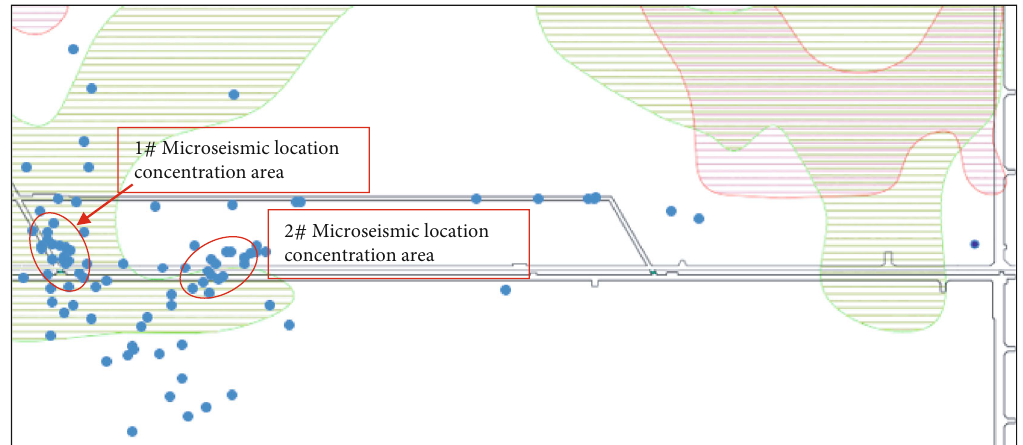
Figure 5: Distribution of microseismic events during the period of the 2202 auxiliary transport roadway excavation.